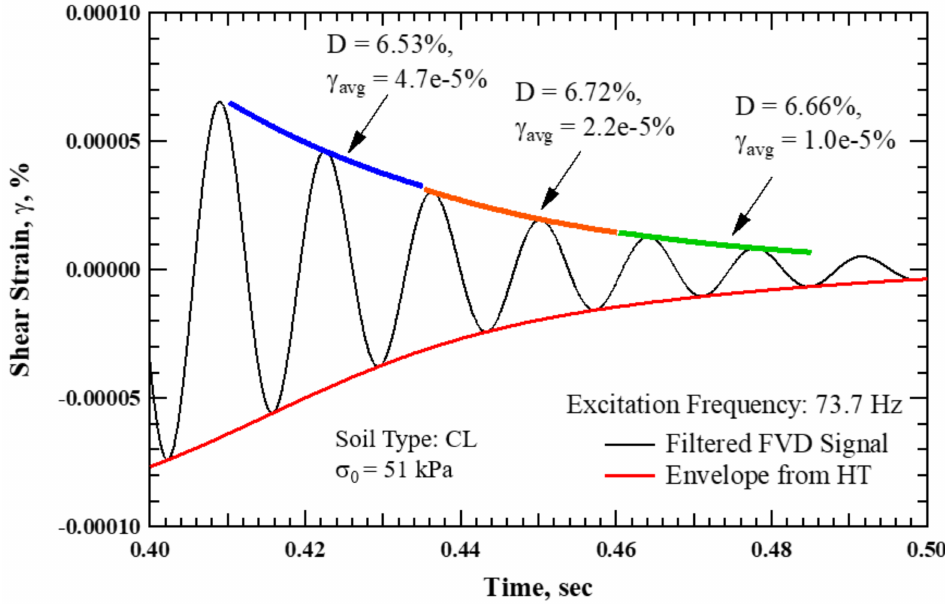
Figure 17. Viscous damping ratio from the proposed method.